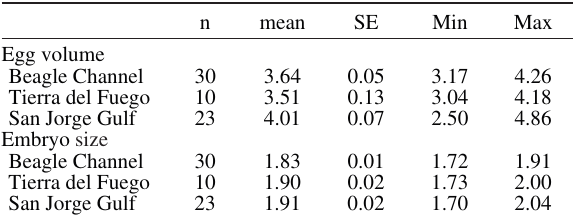
Table 3. – Egg volume (mm 3 ) and embryo size (mm) at the three sampling